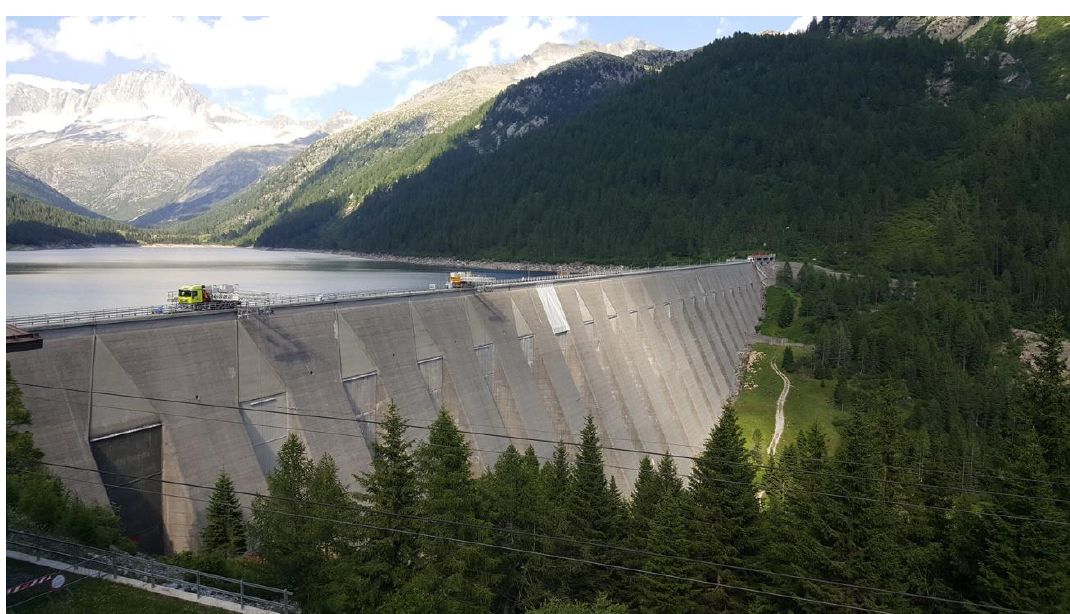
Figure 5. Bissina Dam—Italy (photo taken by the author on 5 July 2019).